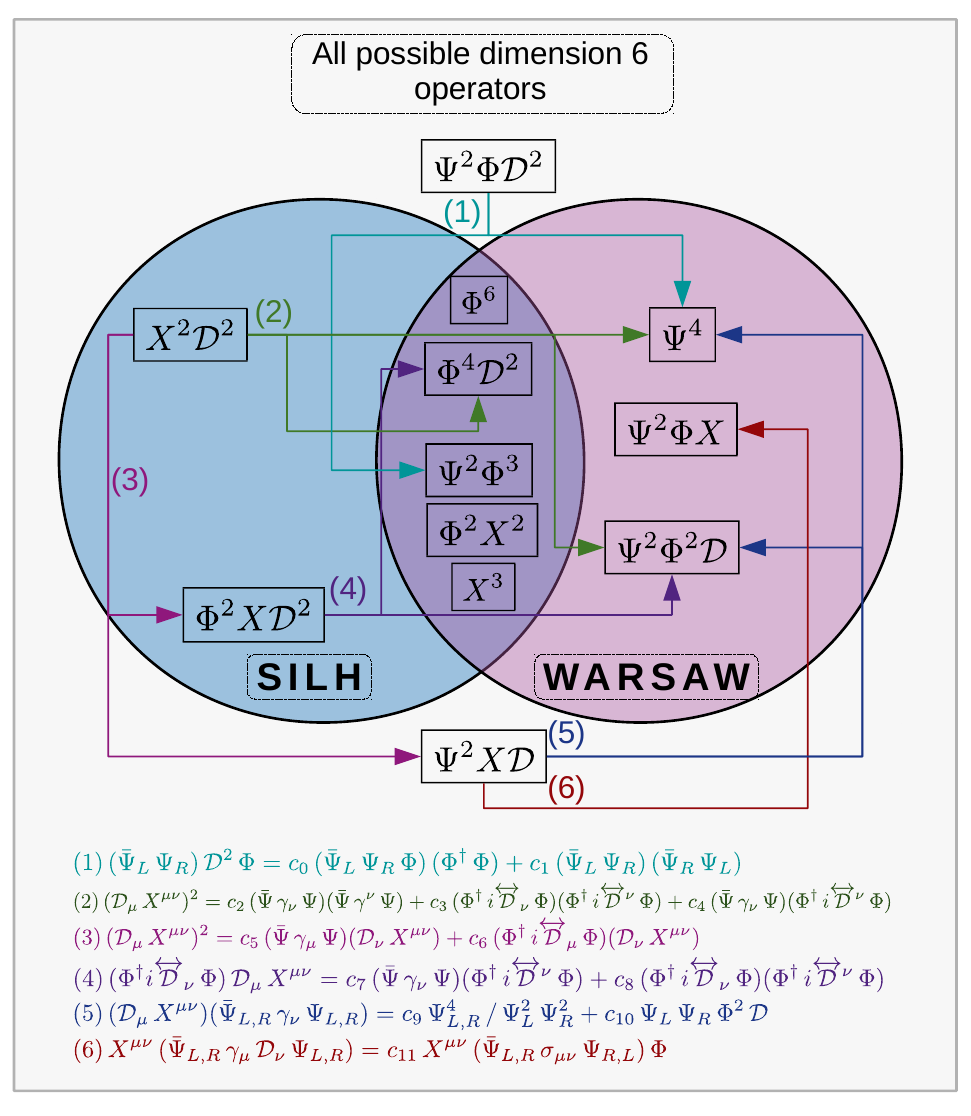
Figure 1 . All possible Lorentz invariant dimension 6 operator classes shown as part of the Warsaw and SILH bases for SMEFT. The arrows depict relations among the classes based on the equations of motion (EOMs) of various